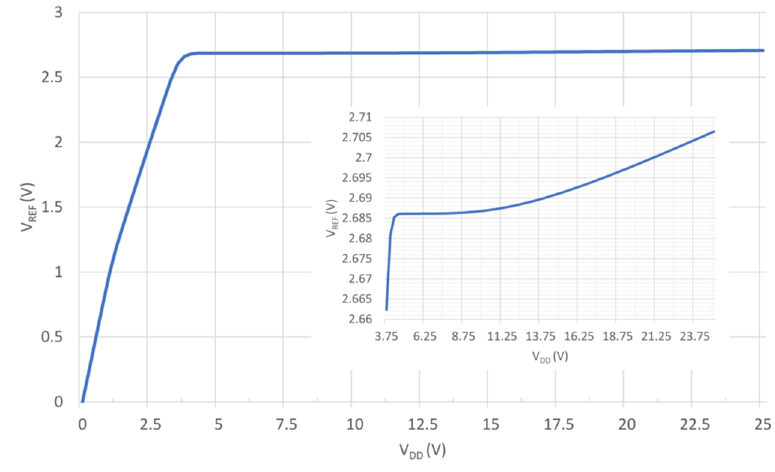
Figure 6. Reference voltage versus supply voltage (TT corner, room temperature).